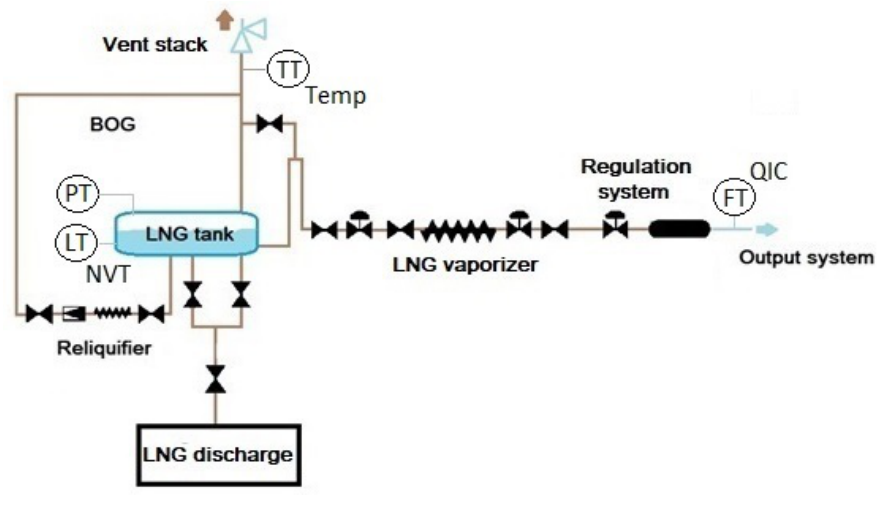
Figure 2. Scheme of LNG satellite